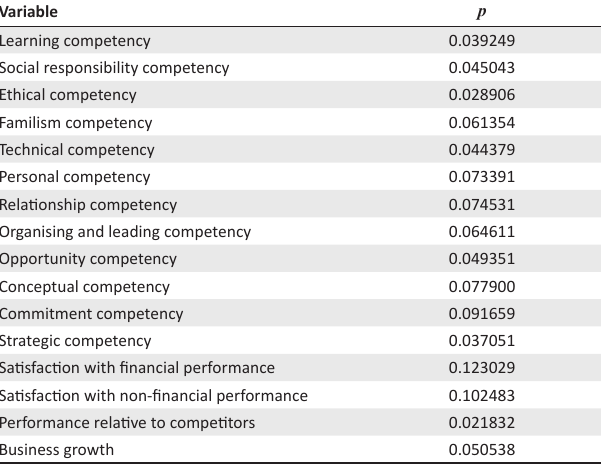
TABLE 3: Correlations of entrepreneurial competencies and business